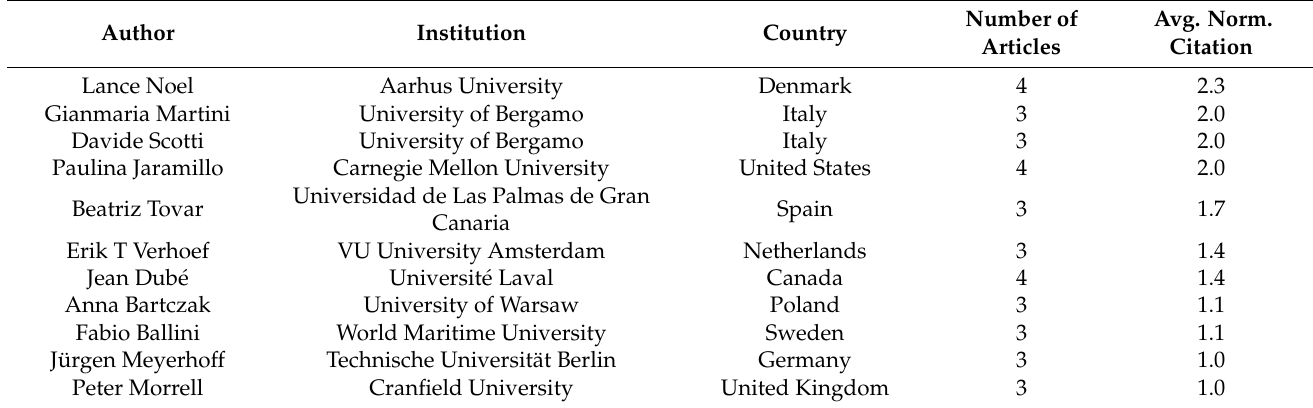
Table 2. The top 11 most influential scholars in infrastructure externalities research.